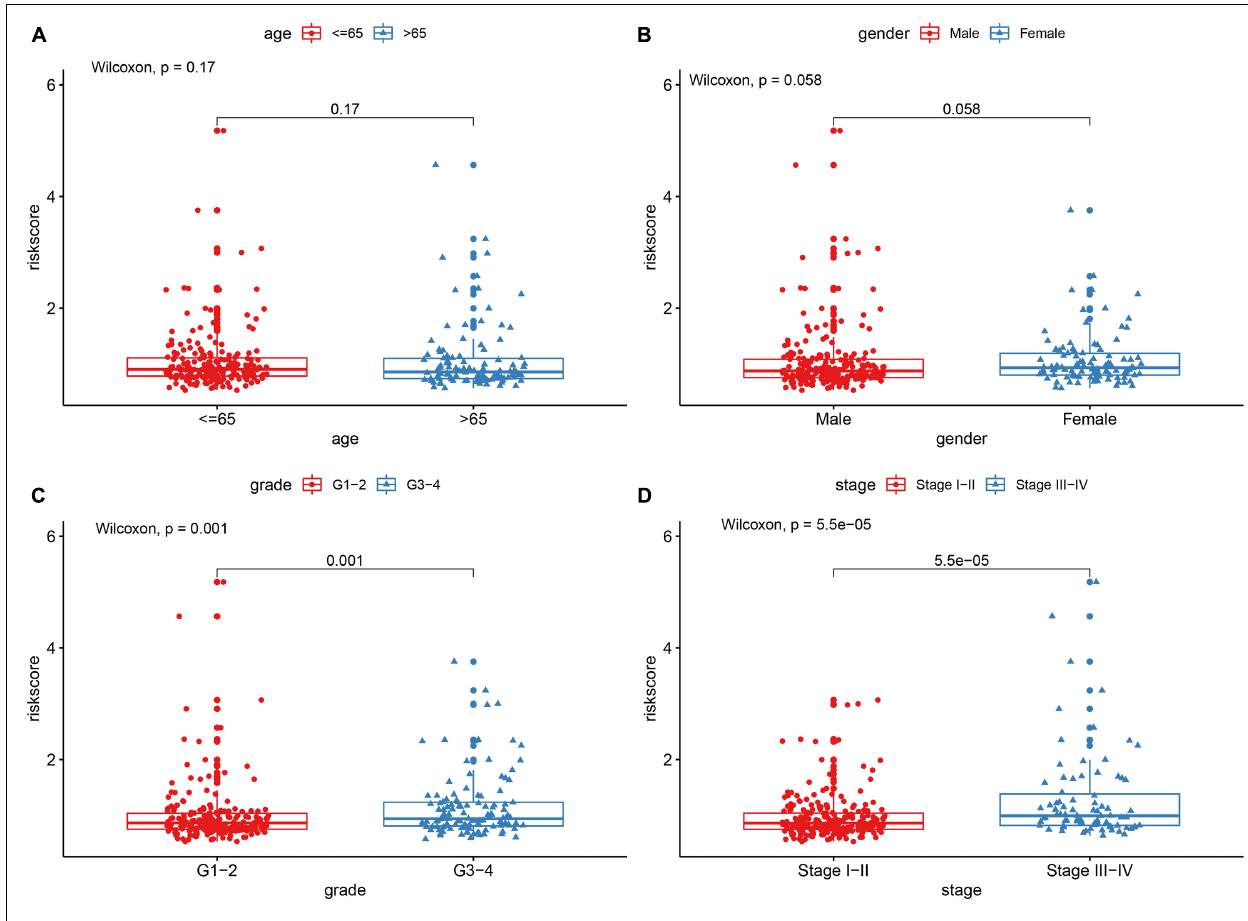
FIGURE 5 | The correlations between the risk model and clinical factors. (A) Age. (B) Gender. (C) Grade. (D) Stage.